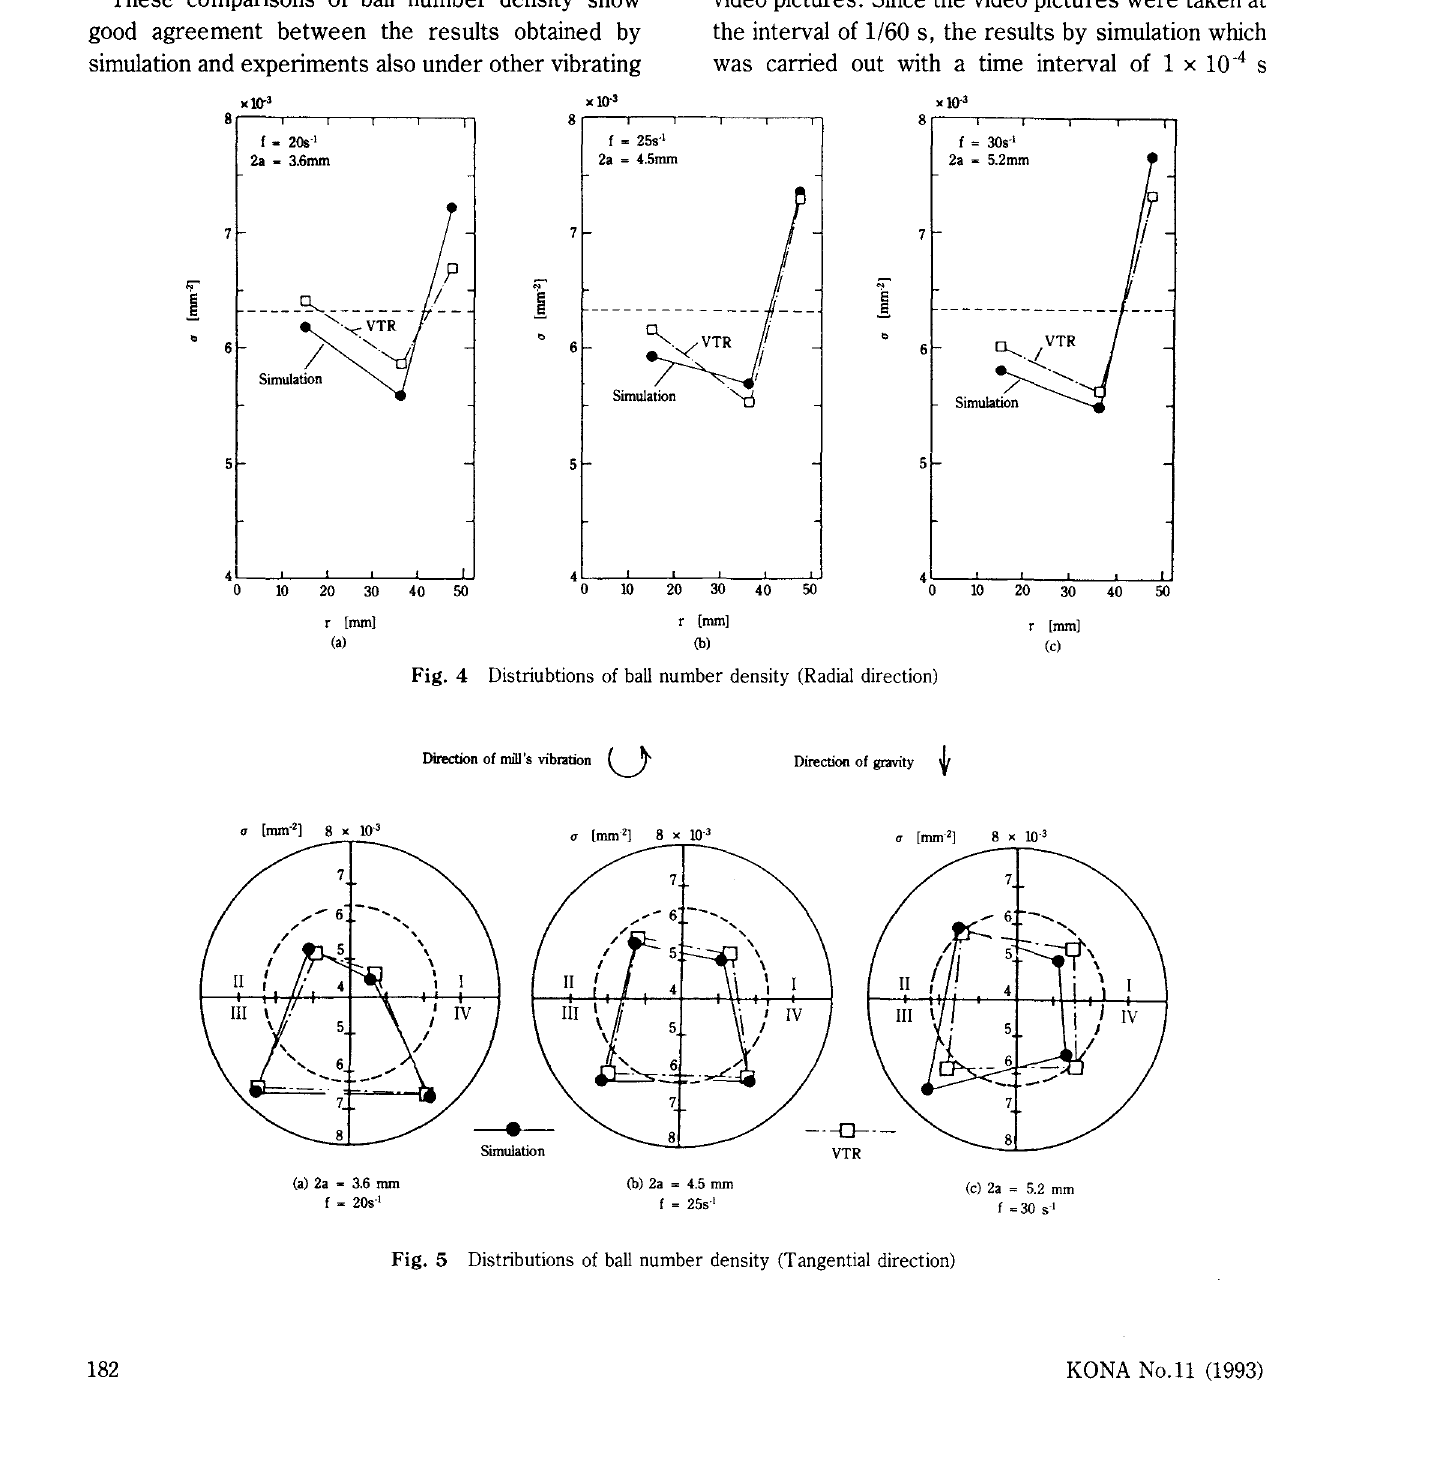
Fig. 4 Distriubtions of ball number density (Radial direction)